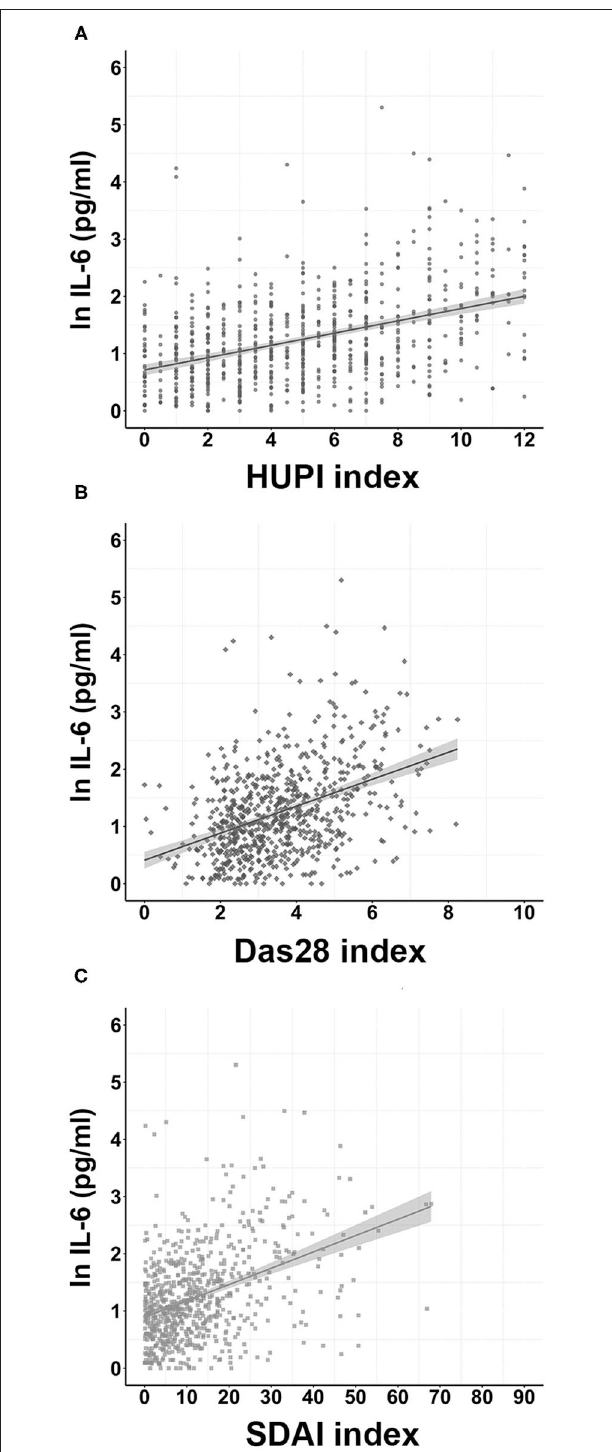
FIGURE 2 | Distribution of IL-6 serum levels according to each disease activity index in the PEARL study through follow-up. (A) , (B), and (C) : Distributions according to the HUPI, DAS28, and SDAI index, respectively. IL-6 level values were transformed to their natural logarithm (nl). Data are shown as dot-plots and their fitted linear prediction (line) with 95% confidence intervals (grey